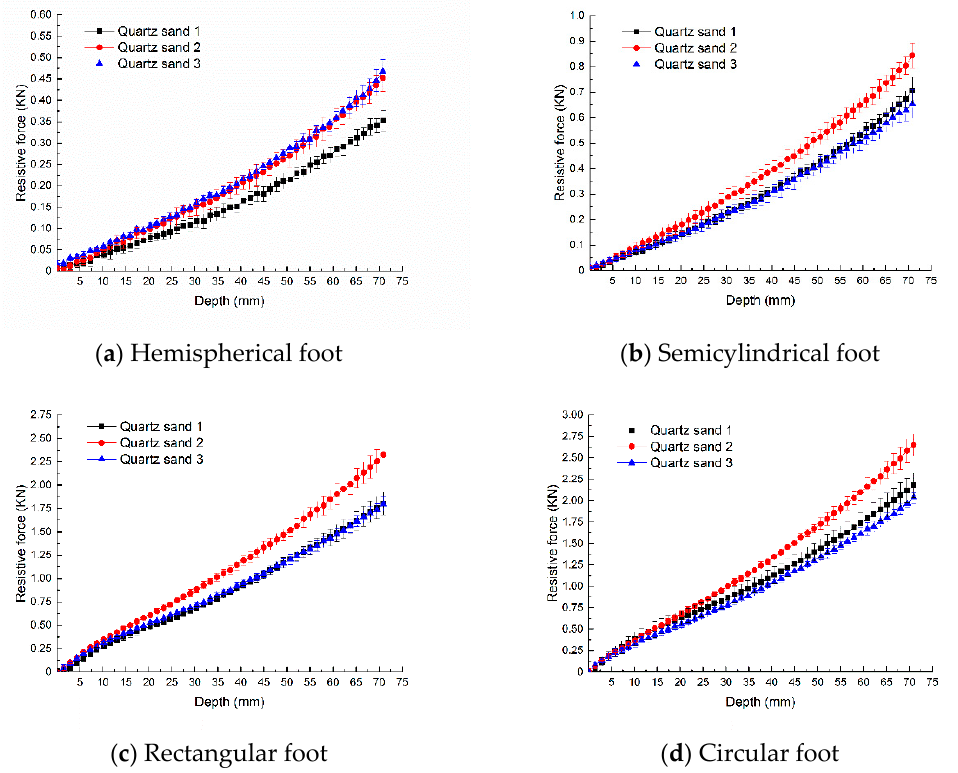
Figure 9. Influence of particle size on the foot intrusion resistive force.